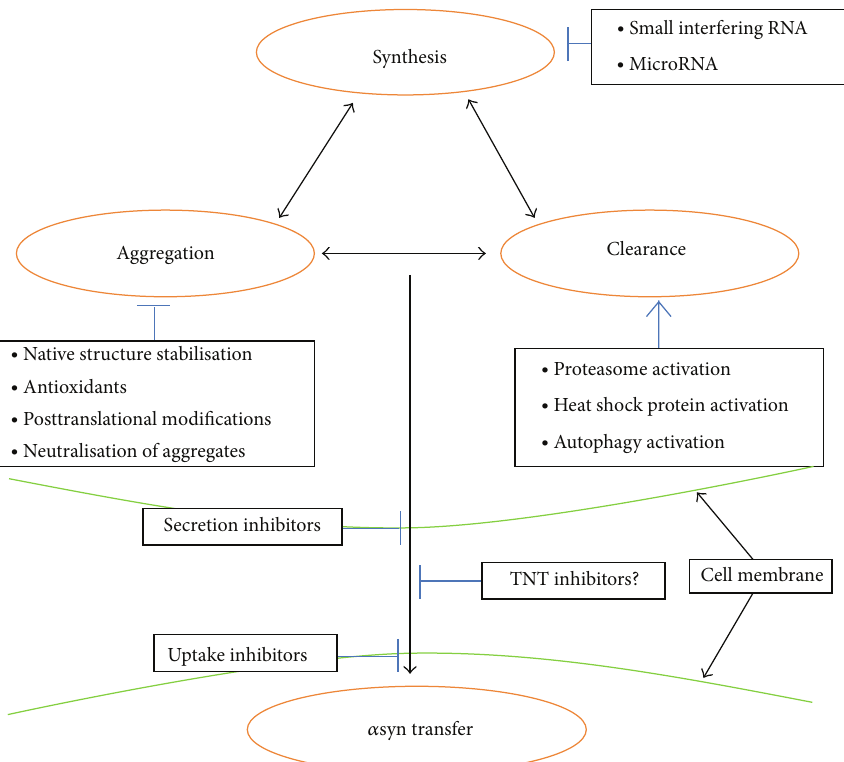
Figure 4: Possible therapeutic strategies to decrease 𝛼 syn transmission in PD. This is not an exhaustive representation; see [7, 57, 59].